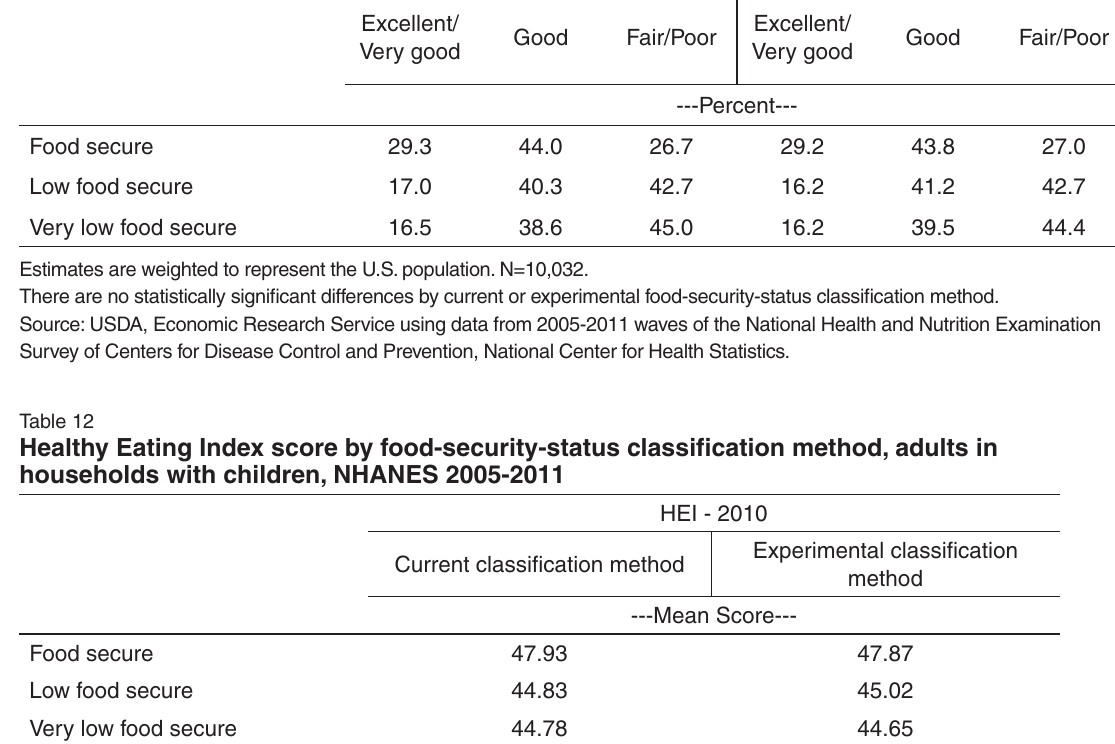
Self-reported dietary quality by food-security-status classification method for adults in households with children, NHANES 2005-2011 Current classification method Experimental classification method Excellent/ Good Very good